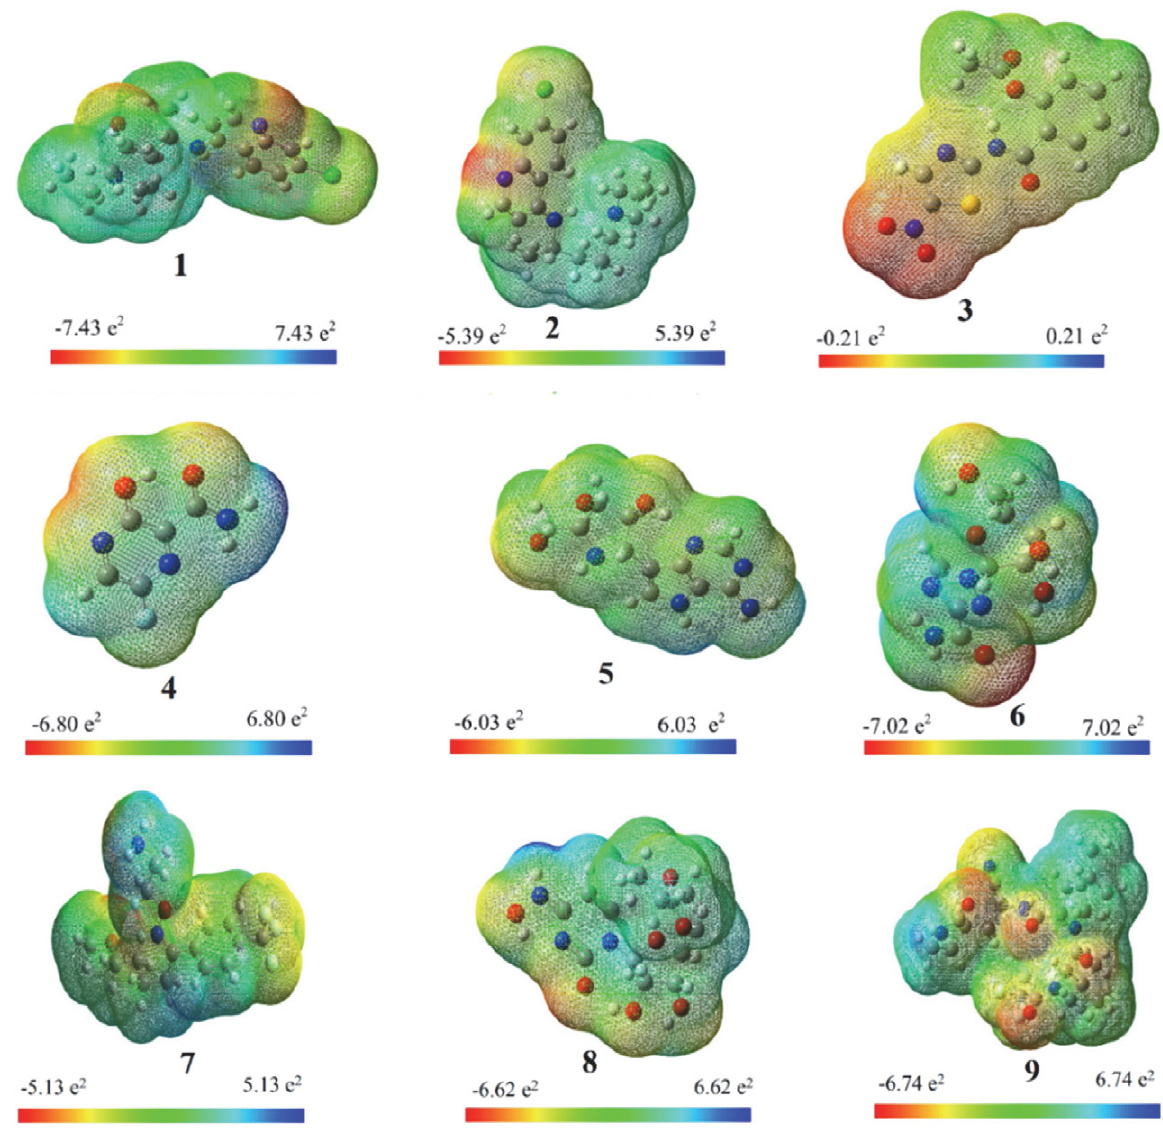
Figure 5. Molecular Electrostatic Potential Plots of